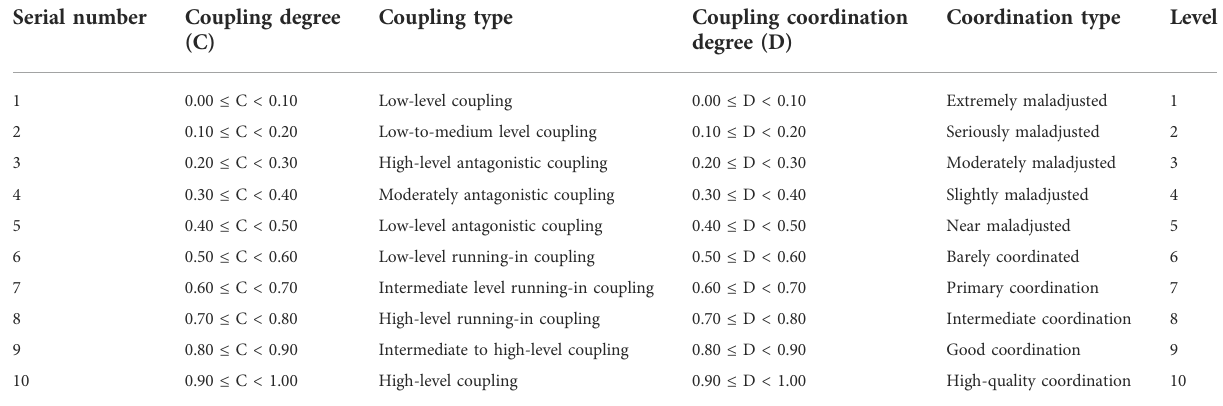
TABLE 3 Level division of the coupling degree and coupling coordination degree between RECC and